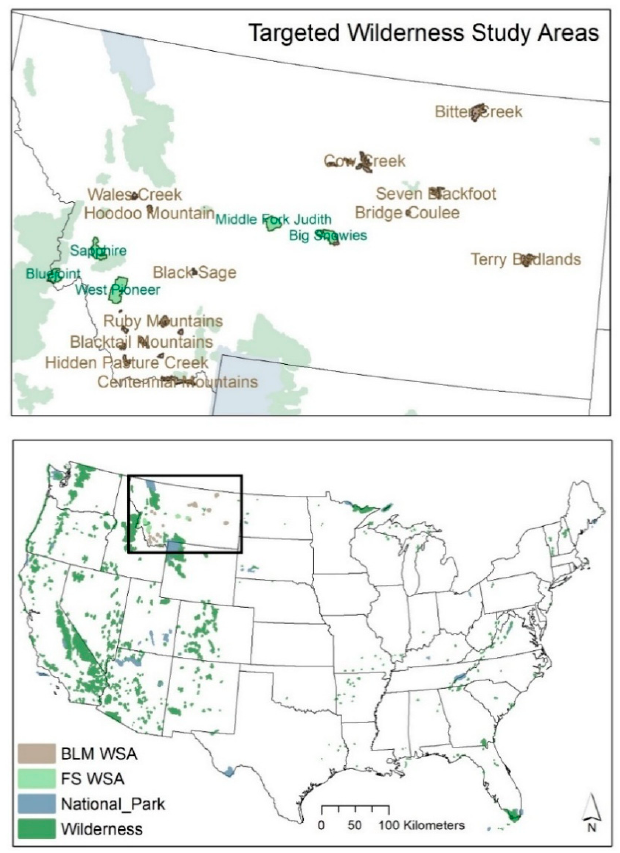
Figure 1. Map of targeted Wilderness Study Areas (WSAs) in Montana ( top ) and all national parks and wilderness areas in the lower 48 states used in this analysis ( bottom ). Not all WSAs are labeled; see Table 2 for full list of WSAs included in proposed legislation aimed at demoting their conservation